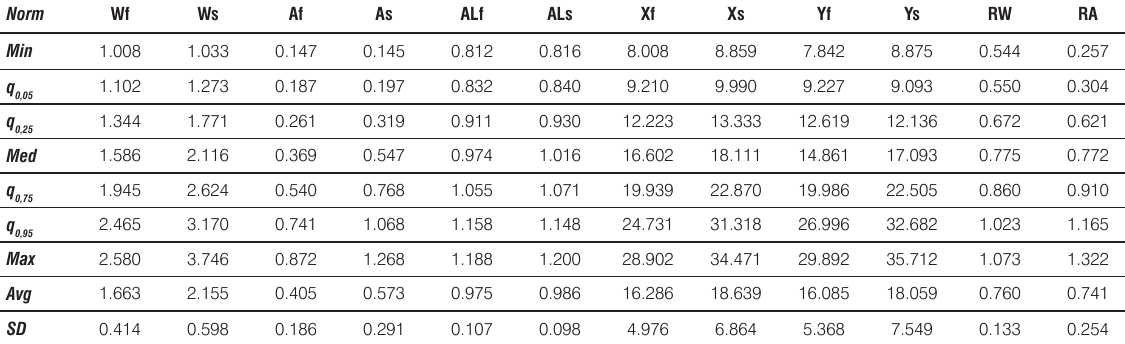
Table 2. Data distribution of observed parameters in patients with no history of vestibular disorder.